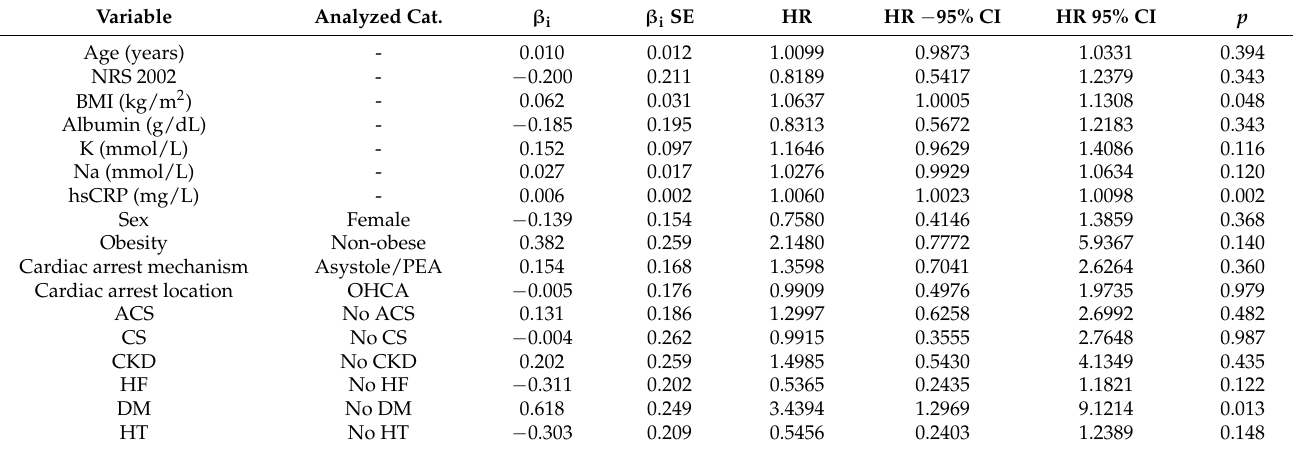
Table 7. Multivariate survival analysis (Cox proportional hazards